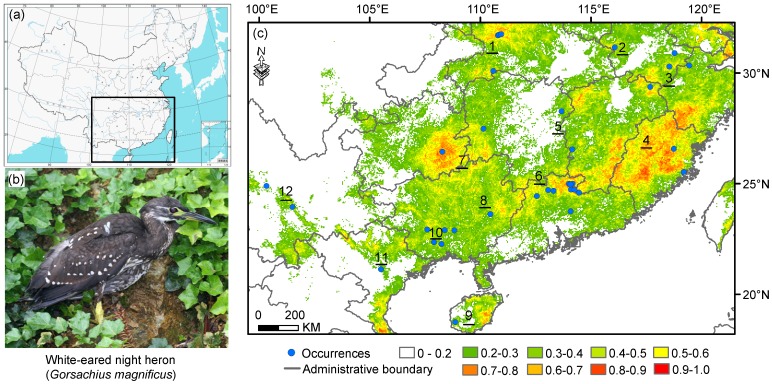
Study area and predicted habitat suitability for the endangered white-eared night heron Gorsachius magnificus.The suitability is displayed in logistic value and ranges from 0 (lowest suitability) to 1 (highest suitability). Blue circles indicate known occurrence records. The Arabic numerals indicate locations of the significant mountain ranges mentioned in this study: 1, Shennongjia Mt.; 2, Dabie Mt.; 3, Huangshan-Tianmu Mt.; 4, Yandang-Wuyi-Daiyun Mt.; 5, Mufu-Jiuling-Luoxiao Mt.; 6, Nanling Mt.; 7, Wuling-Xuefeng-Miaoling Mt.; 8, Dayaoshan Mt.; 9, Limuling-Wuzhishan Mt.; 10, Shiwan'dashan Mt.; 11, Ban Thi & Xuan Lac; 12, Ailao Mt.